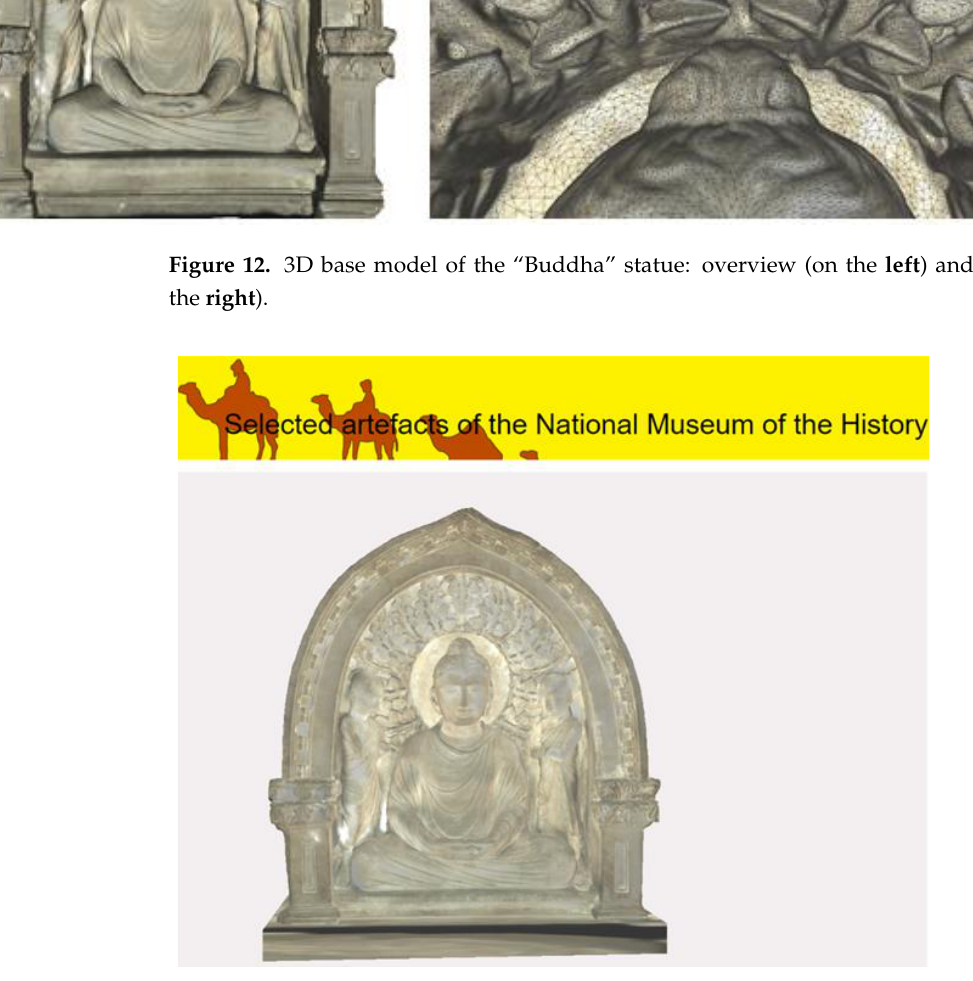
Figure 12. 3D base model of the “Buddha” statue: overview (on the left ) and mesh visible (on the right ).